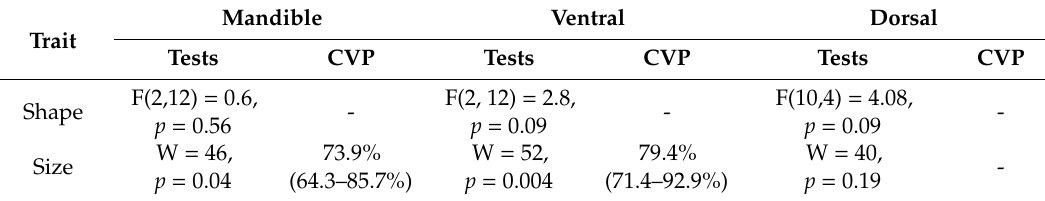
Table 2. Test of di ff erences between captive and wild hybrids. Di ff erences in shape and size were tested using MANOVA and Wilcoxon’s tests, respectively, for the ventral and dorsal sides of the cranium and the mandible. P: p -value, numDf and denDf: Numerator and denominator degree of freedom. Cross-validation percentages (CVP) are provided as the mean and the 90% confidence interval (CI) of the distribution.